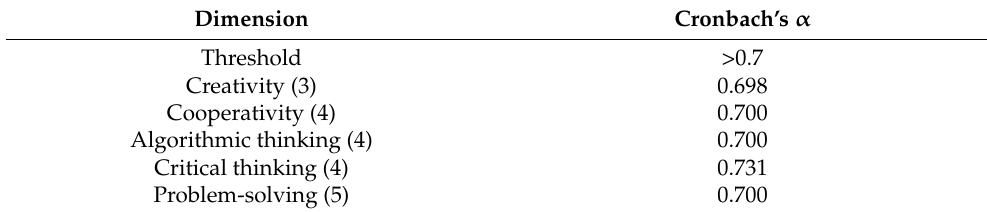
Table 2. Reliability of the revised CT scale.